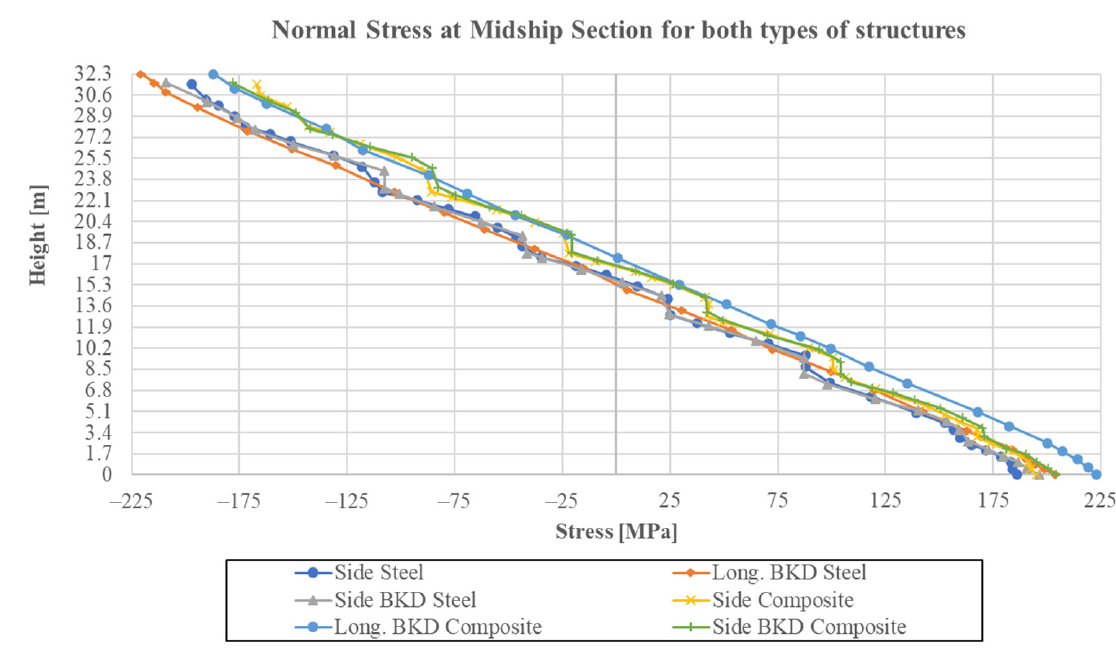
Figure 9. Normal stress distribution for the side, center and side longitudinal bulkhead.